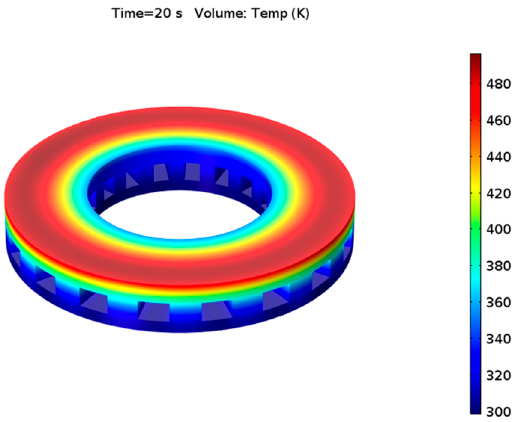
Figure 15. Cloud charts of temperature distribution for traditional friction brake disc.